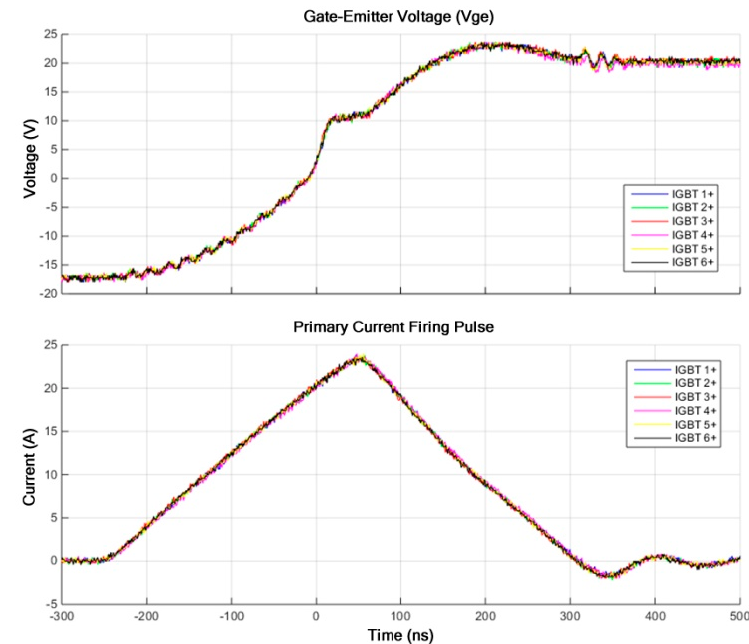
Figure 12. Perfect synchronization between the gate-emitter (Vge) voltages of the six series-connected IGBTs. The primary current pulses are shown proving the temporal determinism of each event.